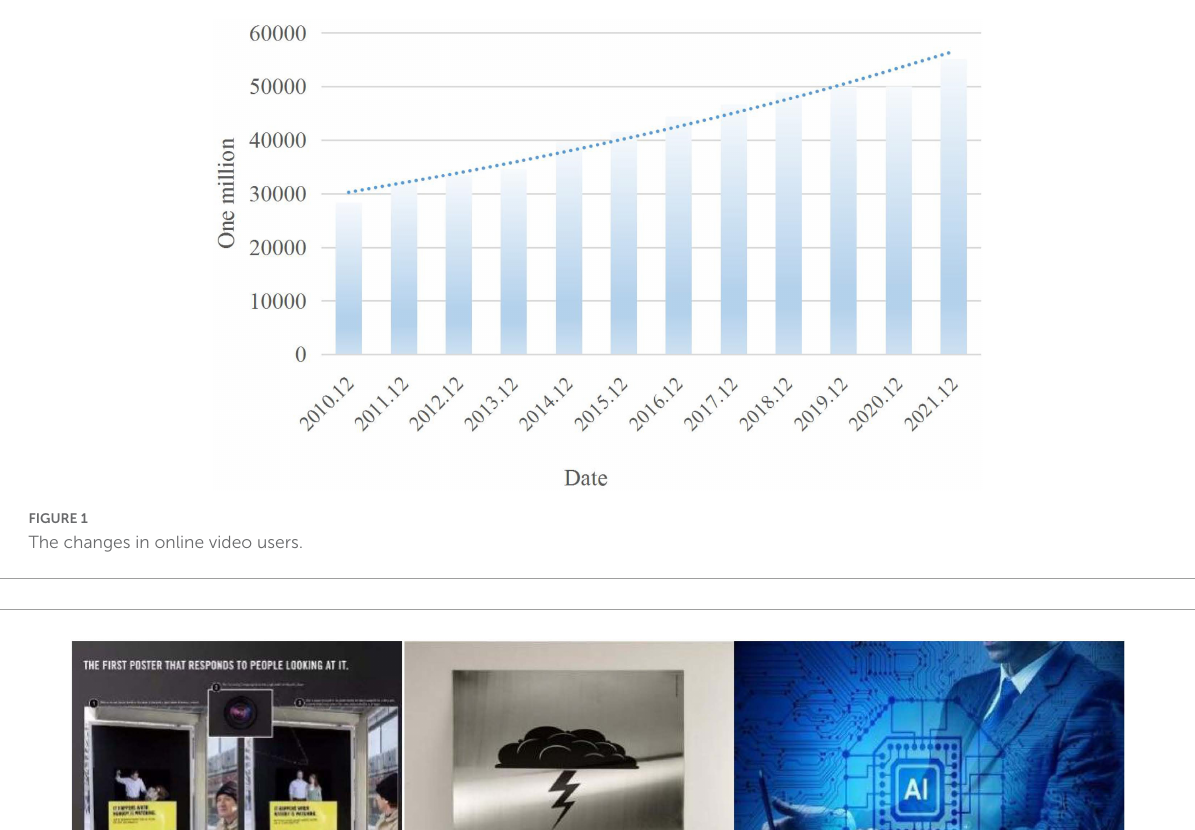
FIGURE2 Representative interactive